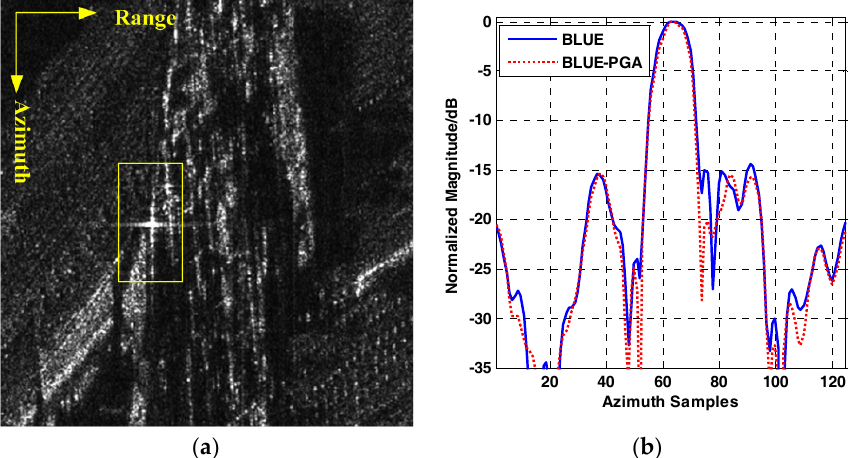
Figure 19. ( a ) Result processed by the combination of the BLUE and PGA (BLUE-PGA) algorithms. ( b ) Azimuth slices of the BLUE and BLUE-PGA